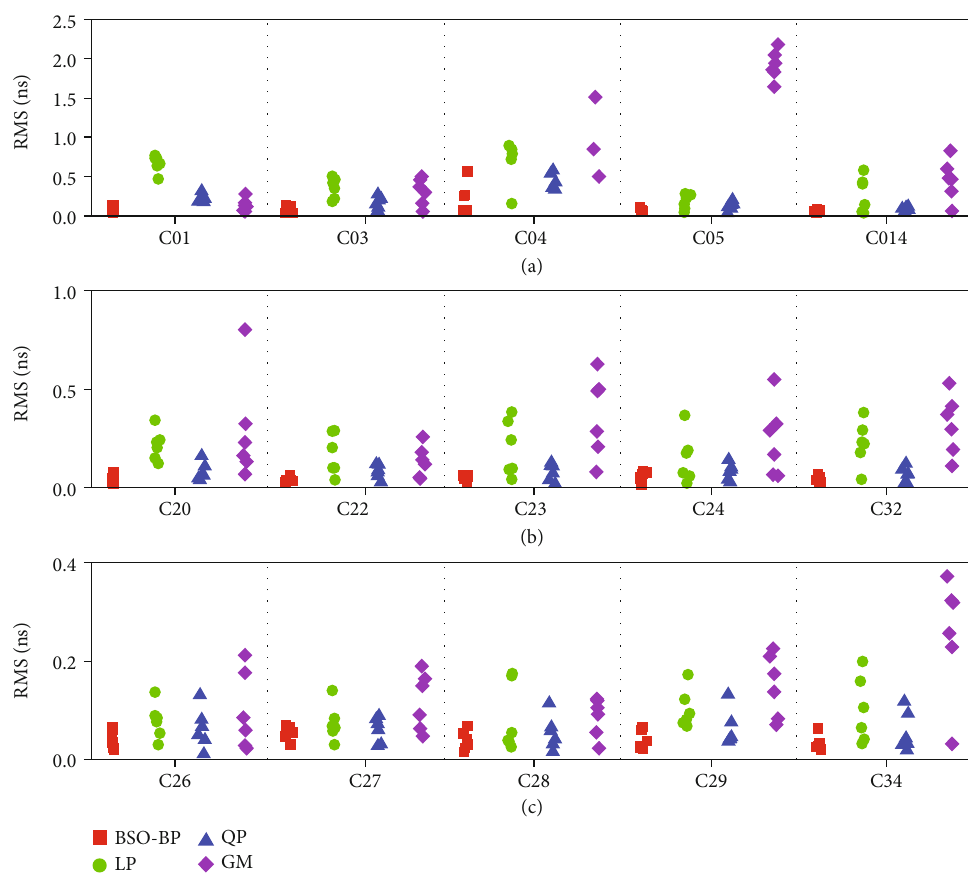
Figure 15: The prediction accuracy of 6 days for 1 hour using 12-hour SCB data: (a) residual distribution of fi ve Rb clocks; (b) residual distribution of fi ve Rb-II clocks; (c) residual distribution of fi ve PHM clocks. Table 5: The average prediction accuracy for 1 hour for three di ff erent types of clocks based on 6-hour and 12-hour SCB data. Clock type